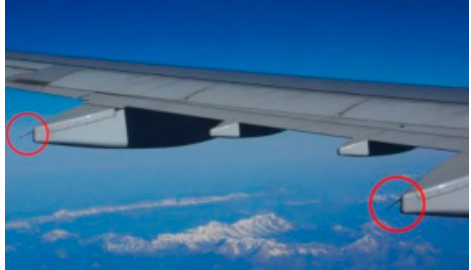
Figure 1. An aircraft can resume its flight safely because of the static dischargers (red circles) attached to its wings to discharge the electric current into the air.